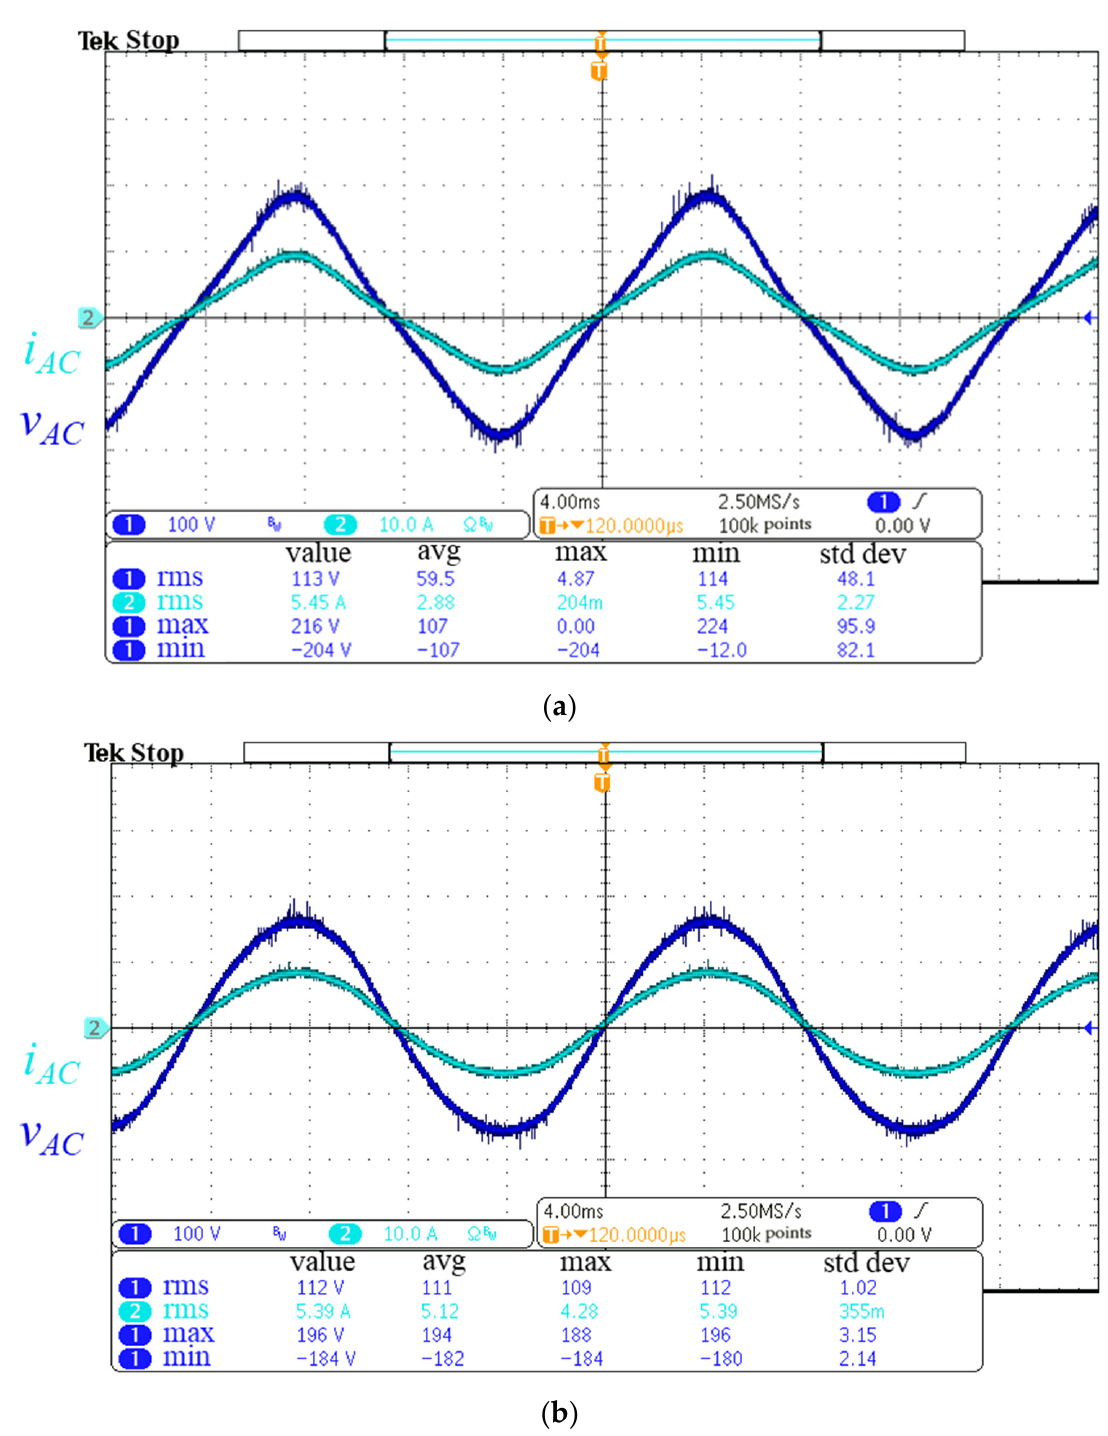
Figure 19. The measured results (500 W) of the voltage and current output waveforms when using ( a ) the traditional SPWM control and ( b ) modified SPWM control.